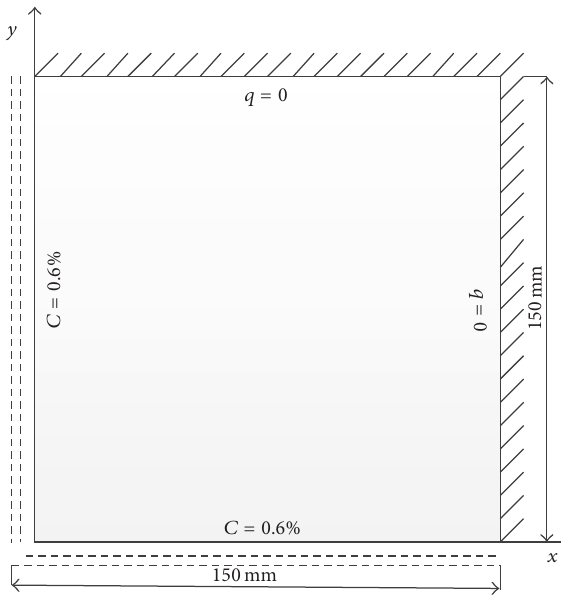
Figure 5: 2D chloride diffusion in a square concrete